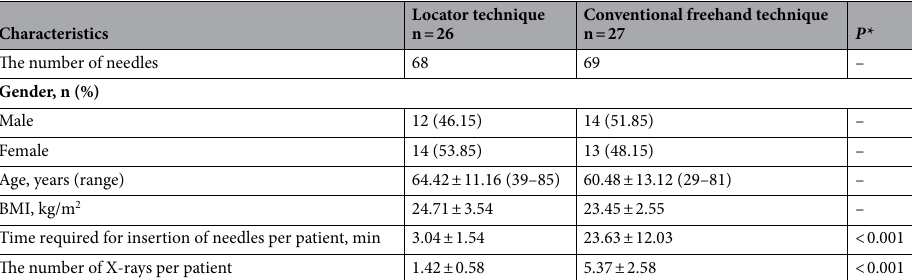
Table 1. Comparison between the efficacy of the locator technique and the conventional freehand technique in MISS. * P- value was assessed by comparing differences between the two groups via the Student’s t-test; BMI body mass index; Time required for placement of needles was the period from the time when the (first) guide needle started to penetrate the skin from point P on skin to the time when standard X-ray fluoroscopy showed that every the needle tip was at the midpoint of the pedicle’s lateral edge, and meanwhile, the X-ray lateral fluoroscopy showed that every guide needle was on the extension line of the pedicle’s midline; The number of X-rays indicated the frequency of taking X-ray fluoroscopy to check the position of guide needles during a